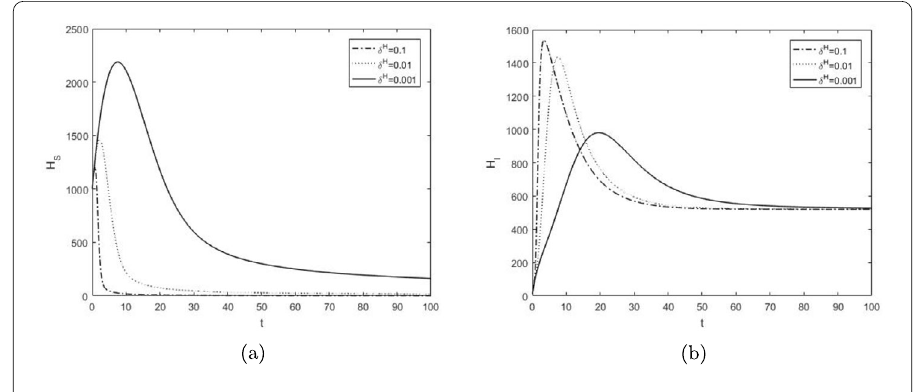
Figure 5 Variation of H S , H I versus t for δ H = 0.1,0.01,0.001